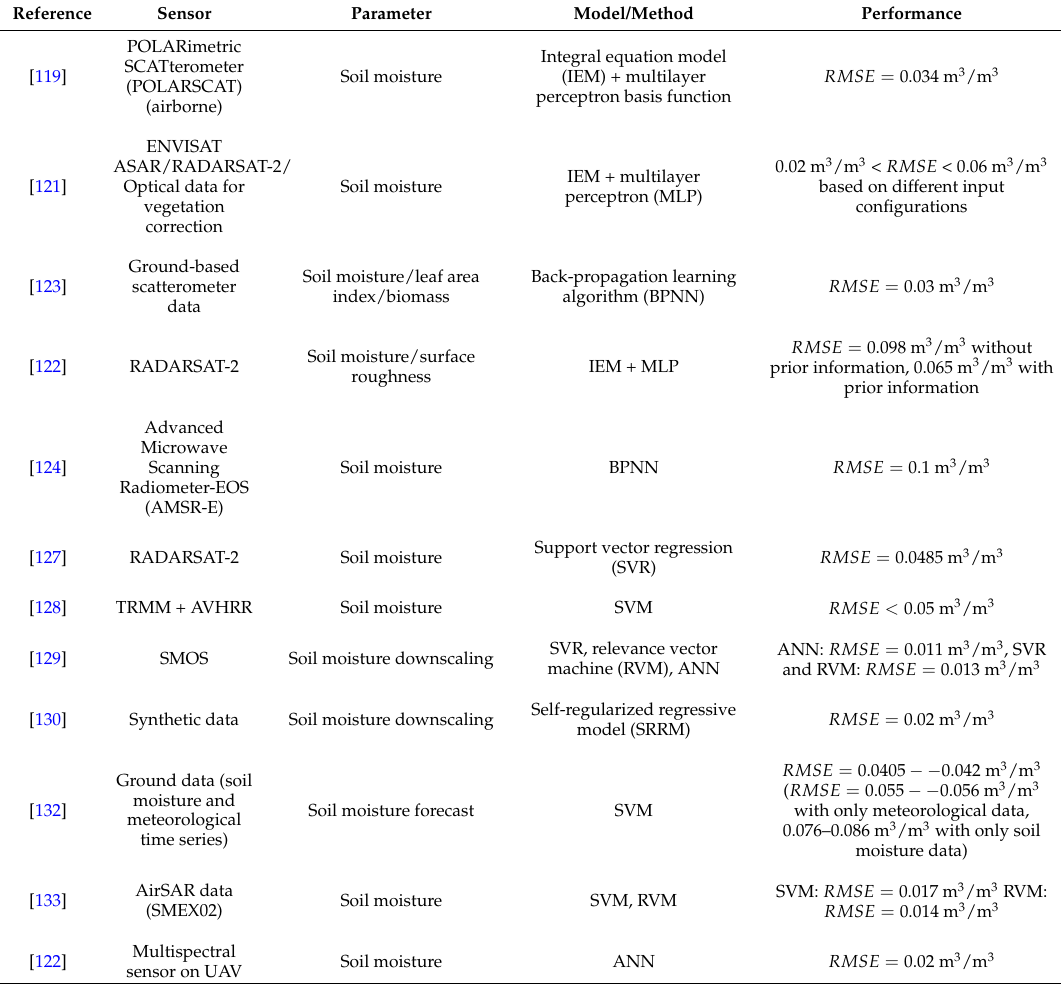
Table 5. Soil moisture retrieval